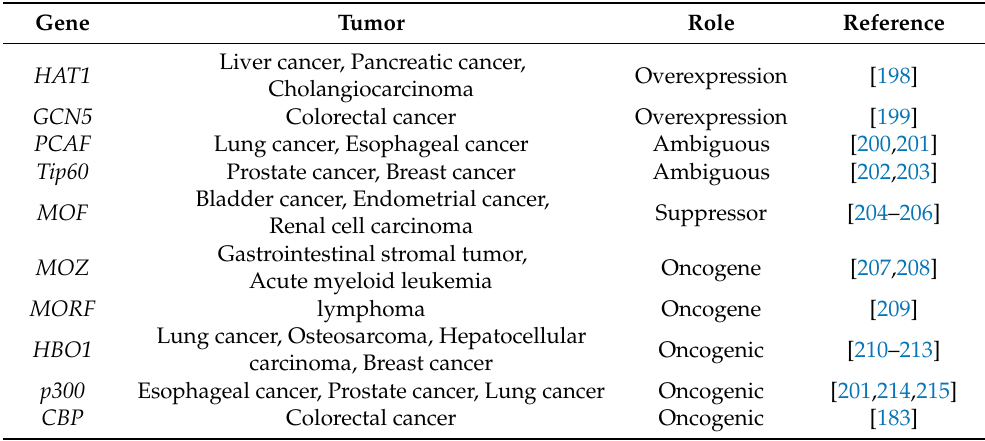
Table 2. The role of genes encoding histone acetyltransferase in human cancer.